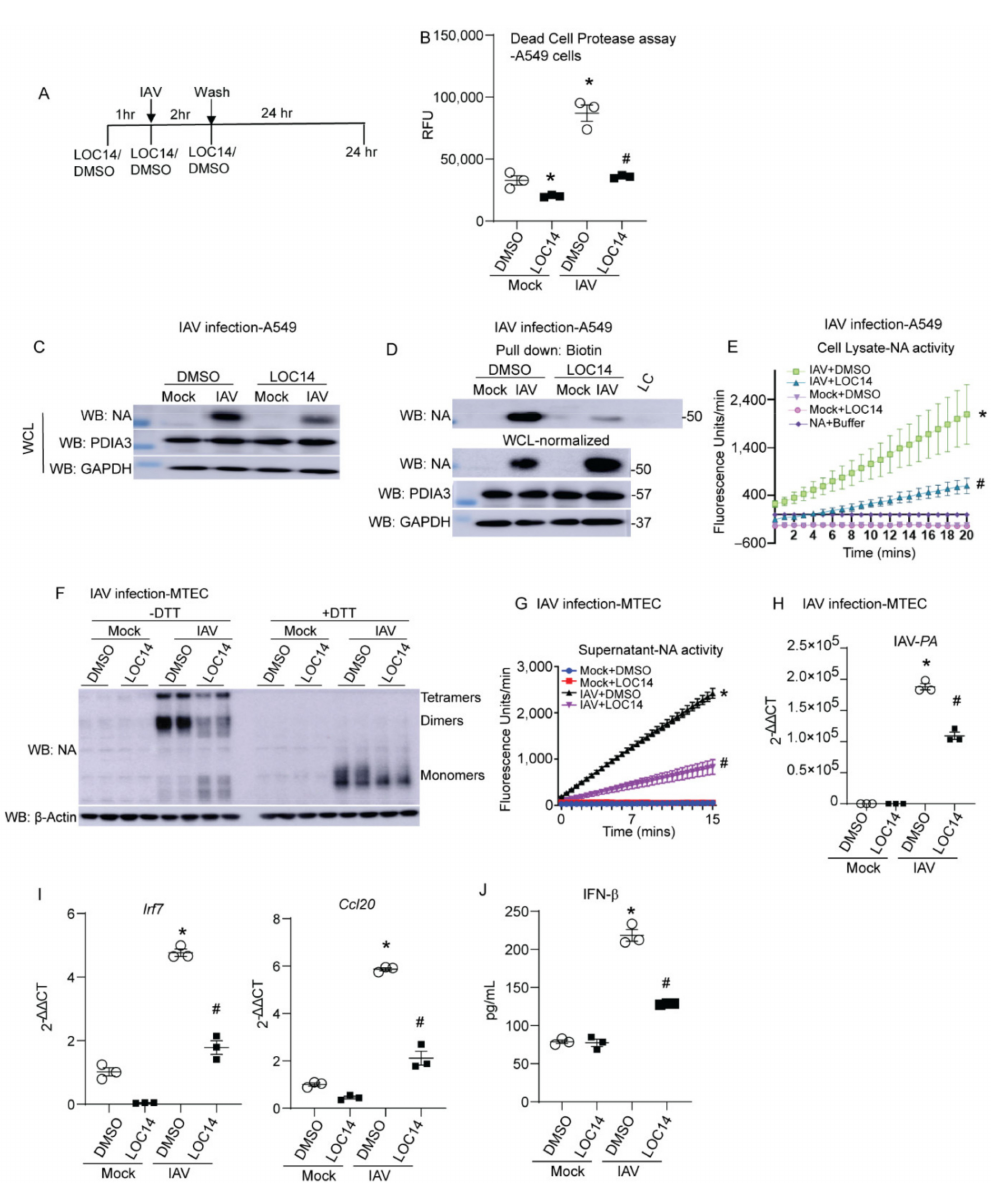
Figure 2. PDI inhibitor LOC14 decreases disulfides in NA, the activity of NA, viral burden, and pro-inflammatory response in primary lung epithelial cells. ( A ) Schematic representing the time points of IAV infection and LOC14/DMSO treatment and harvest in cells. ( B ) Dead cell protease assay (RFU—relative fluorescence units). ( C ) Western blot analysis of influenza NA, PDIA3 in H1N1 PR8 or mock virus-infected A549s treated with vehicle control (DMSO) or LOC14. ( D ) Western blots of NA labeled for disulfides in samples spiked with 1.5 × higher total protein in cells treated with LOC14. ( E ) NA activity from the cell lysates infected with H1N1 PR8 or mock virus and treated with vehicle control (DMSO) or LOC14. ( F ) Oligomerization of NA in IAV or mock virus-infected MTECs treated with vehicle control (DMSO) or LOC14, Western blot ± DTT. ( G ) Influenza-NA activity measurement from cell supernatants of MTECs infected with IAV or mock virus and treated with vehicle control (DMSO) or LOC14. ( H ) Influenza-PA mRNA measurement from cell lysates of MTECs infected with H1N1 PR8 or mock virus and treated with vehicle control (DMSO) or LOC14. ( I ) Measurement of Interferon regulatory factor 7 (Irf7) or Ccl20 mRNA. ( J ) Measurement of IFN β by ELISA. * p < 0.05 compared to mock + DMSO group, # p < 0.05 compared to IAV + DMSO group, by ANOVA. Data are expressed as the standard error of the mean ( ±